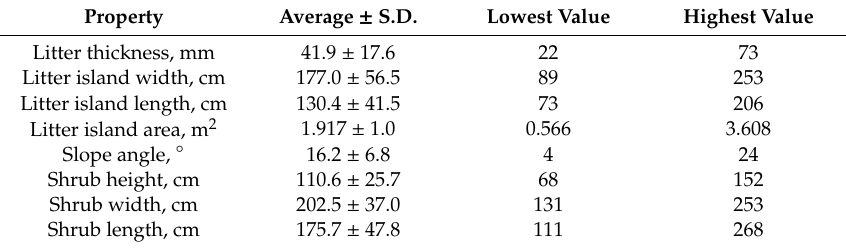
Figure 3. Spatial distribution of surface litter beneath a k¯upaoa shrub; diagram shows average dimensions of shrubs and litter islands (Lis) sampled (Table 1). LI is shown by stippled texture. Upslope is to the top; small blank arrow at bottom indicates slope direction. Scale is 1 m long. Key . T: shrub trunk; S: location of litter and soil samples; A – B : Shrub and / or litter island width across the slope; C – D : Downslope shrub length ; T – L : Downslope litter island length ; PS : Location of paired soil sample, ~150–200 cm from canopy edge. Direction of prevailing NE trade winds is shown by a dark dash-line arrow on the lower left; north direction is shown by a large blank arrow. Table 1. Average values ( ± S.D.) and value ranges for litter islands under the canopy of k¯upaoa shrubs at ~2610–2710 m, and for the shrubs associated with these litter islands, Haleakal¯a crater. Litter thickness reported was measured next to the shrub stem. See text for additional details.